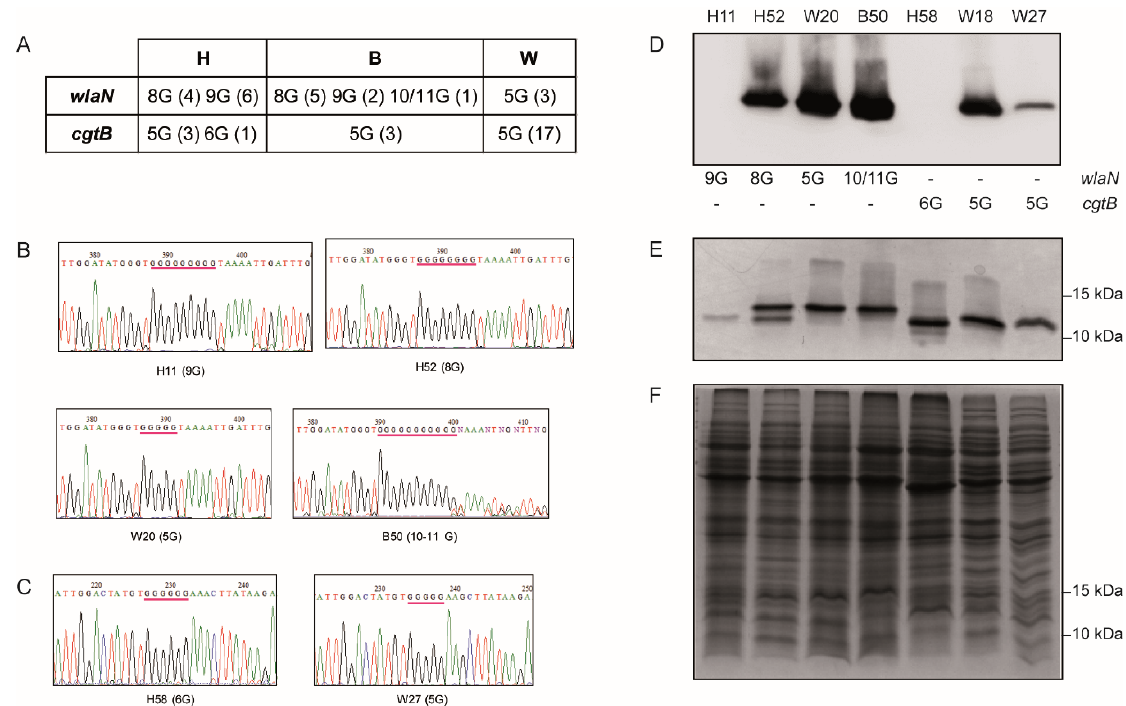
Figure 2. G ‐ tract characterization within the wlaN and cgtB genes. ( A ) Homopolymeric G ‐ tracts identified in wlaN and cgtB genes from human (H), broiler chicken (B), and wild bird strains (W). The different homopolymeric variants identified are indicated and the number of strains is shown between parentheses. ( B ) Sequence of the intragenic homopolymeric G ‐ tracts (indicated by red lines) of the wlaN gene of the strains H11, H52, W20, and B50. The number of G residues within the G ‐ tract are indicated between parentheses. ( C ) Sequence of the intragenic homopolymeric G ‐ tracts (indicated by red lines) of the cgtB gene of the strains H58 and W27. The number of G residues within the G ‐ tracts are indicated between parentheses. ( D ) Detection of LOS SIAL in purified LOS samples from cultures of the indicated strains grown onto CBA plates for 48 h at 42°C. LOS SIAL was detected by Western blot using HRP ‐ CT. Below, the presence for each strain of either the wlaN or cgtB gene is indicated and the G ‐ tract variant detected. ( E ) Silver ‐ stained 15% SDS ‐ PAGE of the same samples of purified LOS as in D. ( F ) Coomassie ‐ stained 15% SDS ‐ PAGE of whole cell extracts from the cultures used to obtain the purified LOS samples analyzed in D and E. In E and F, the migration of the 10 and 15 kDa proteins from the molecular mass marker are indicated.